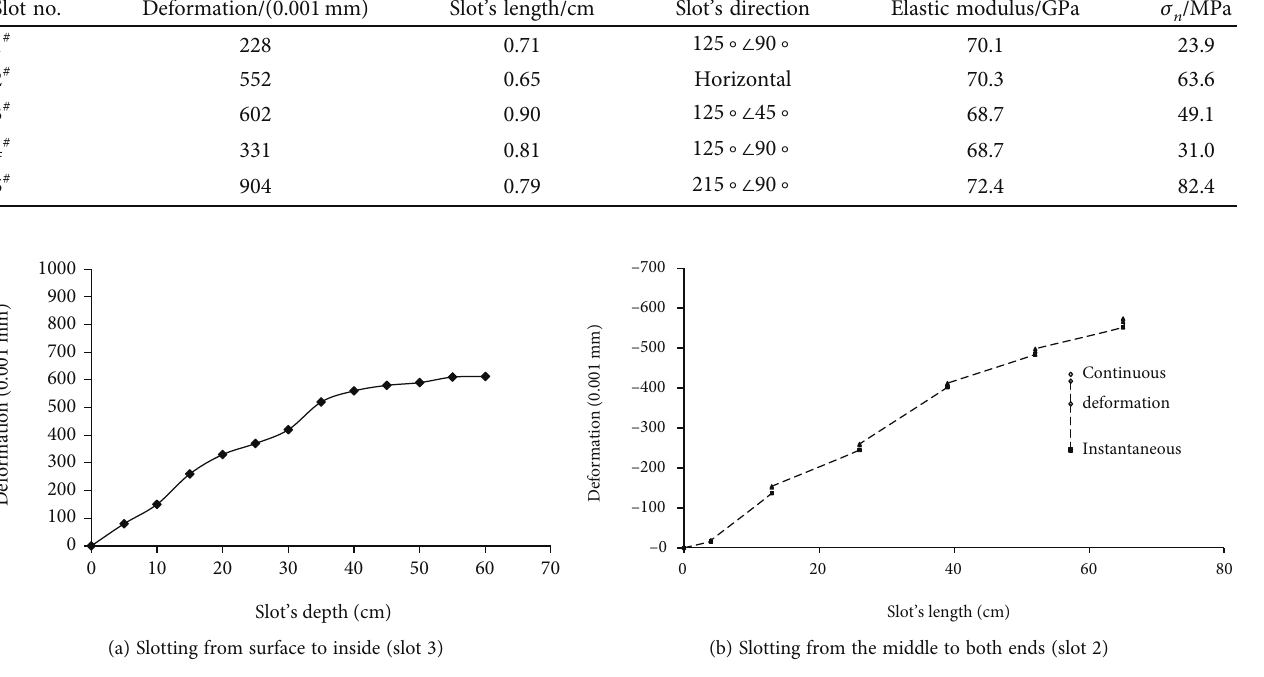
Figure 12: Curve of typical stress relief process.